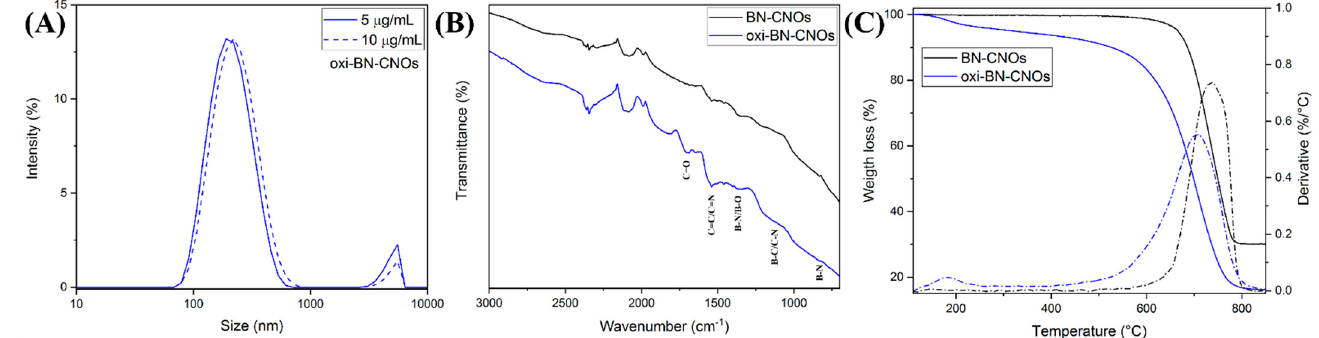
Figure 5. ( A ) DLS spectra of oxi-BN-CNO dispersions in deionized water at concentrations of 5 and 10 μ g/mL. ( B ) FTIR spectra and ( C ) TGA (solid lines) and corresponding weight loss derivatives (dotted lines) of BN—(black) and oxi-BN- CNOs (blue). Table 4. Hydrodynamic diameters of oxi-BN-CNOs at 5 and 10 µ g/mL in deionized water from DLS analyses and weight loss (w.l.) at 450 ◦ C, decomposition temperatures and residues at 850 ◦ C of BN- and oxi-BN-CNOs from TGA